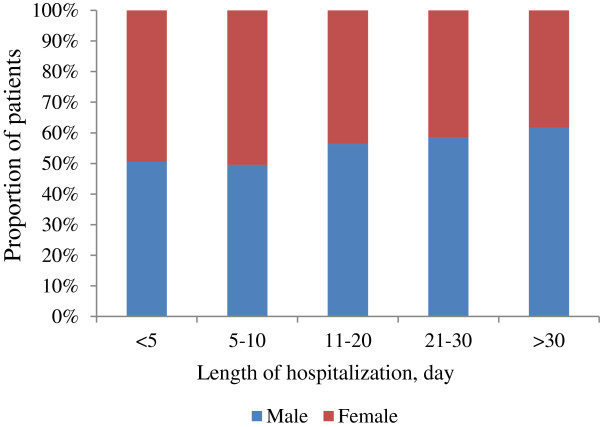
Hospital admissions by gender, by length of hospitalization.